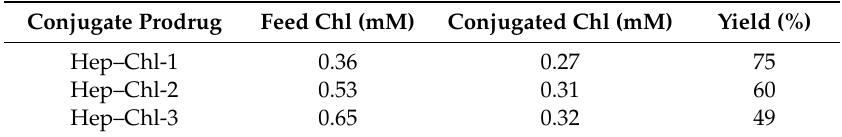
Figure 3. ( a ) UV-vis spectra of Hep, Hep-Cys, Chl, and Hep–Chl. ( b ) The concentration of Chl absorbance for the calibration curve at 304 nm. Table 1. Coupling reaction of heparin-chlorambucil